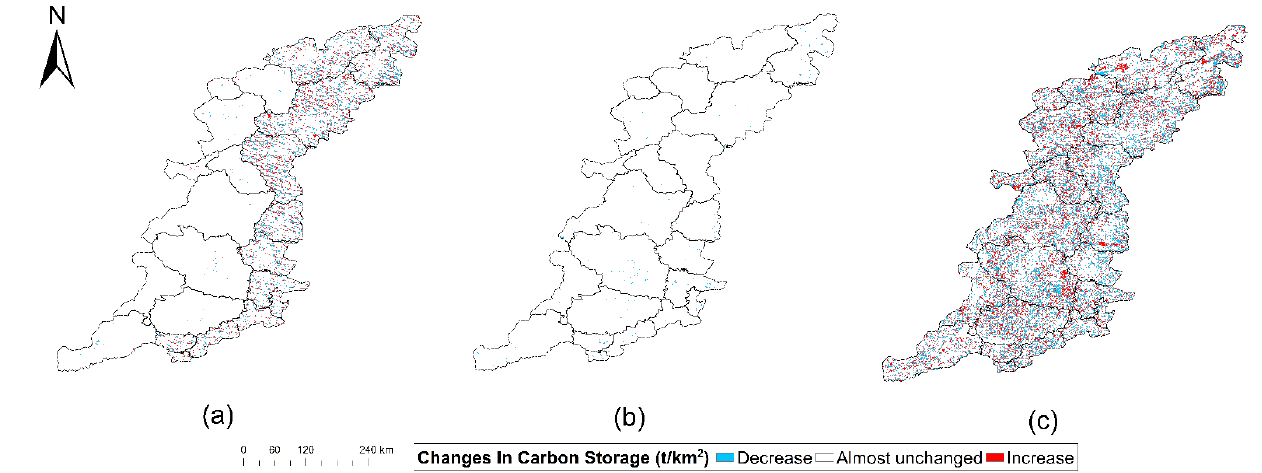
Figure 5. Changes in the spatial distribution of carbon storage in the Taihang Mountains in different periods: ( a ) 2005 – 2010; ( b ) 2010 – 2014; ( c ) 2015 –